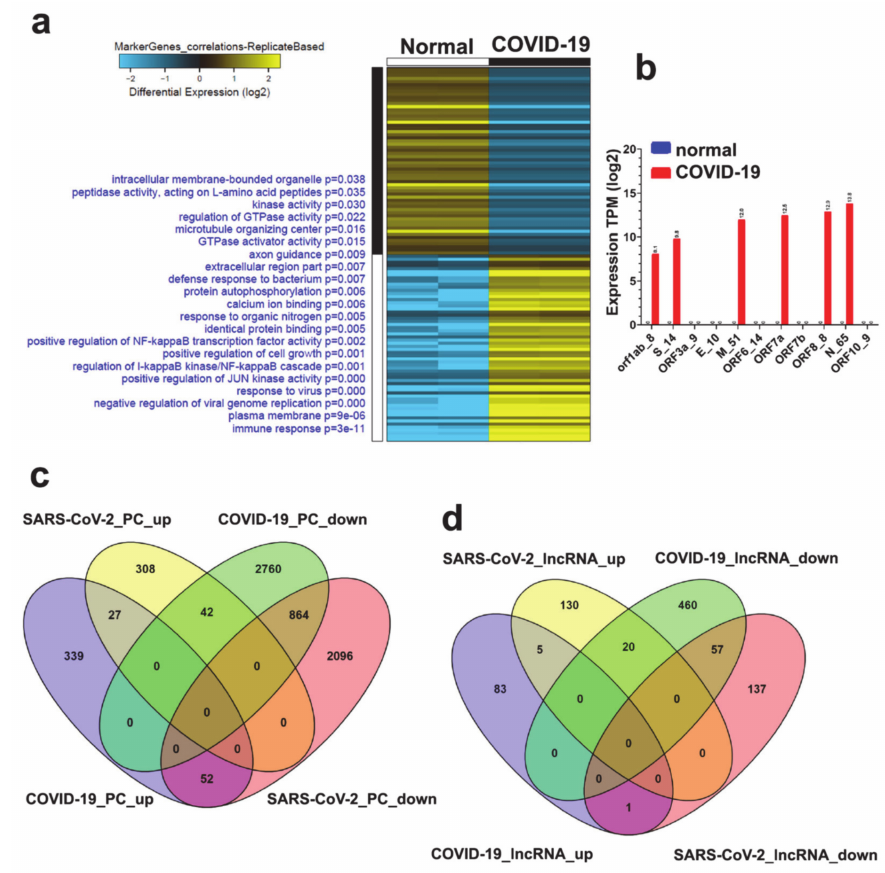
Figure 5. Alteration in mRNA and lncRNA expression in lung biopsies from patient with COVID-19. ( a ) Marker discovery analysis to identify putative markers that are selectively expressed in the lungs from COVID-19 subjects compared to normal lung tissue. Enriched gene ontology (GO) associations are indicated on the y axis (left) while gene guides are listed on the right side. ( b ) Relative expression of the indicated viral genes in lung tissue from COVID-19 patient. Comparative analysis of di ff erentially expressed mRNAs ( c ) and lncRNAs ( d ) in NHBE compared to patient-derived lung